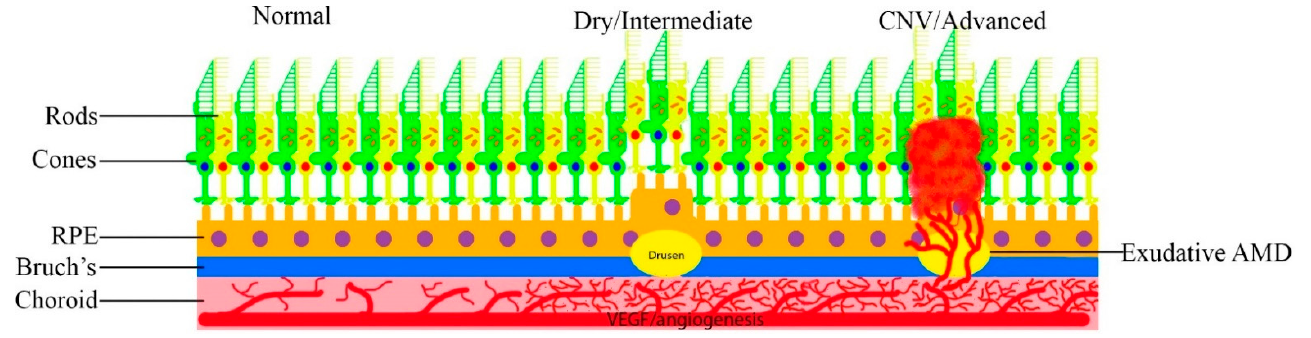
Figure 2. Progression of AMD.